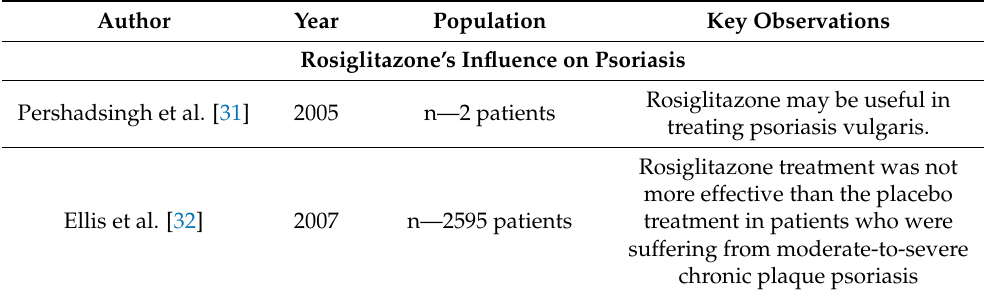
Table 12. Summary of the studies on rosiglitazone’s influence on